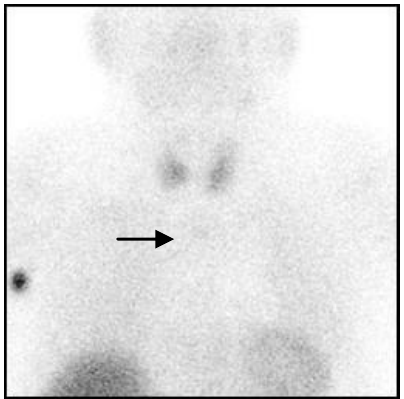
Fig. 4 99m Tc-MIBI 2h plane imaging of substernal heterotopic para- thyroid glands